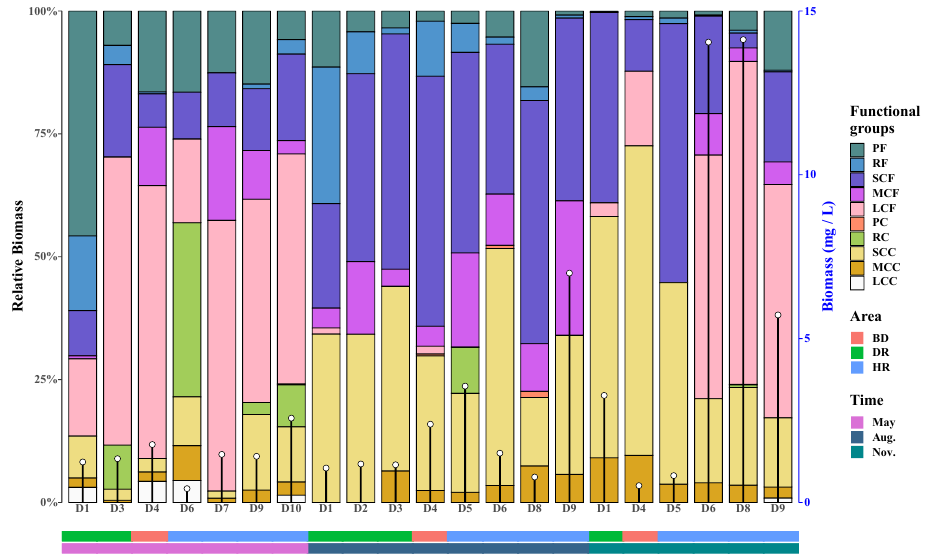
Figure 6. The composition of zooplankton functional groups. The relative biomass of functional groups and total biomass of zooplankton at each site in different sampling months are shown using a stacked histogram (left y -axis) and lollipop chart (right y -axis), respectively. HR: Hanjiang reservoir area, DR: Danjiang reservoir area, BD: the area close to the dam.